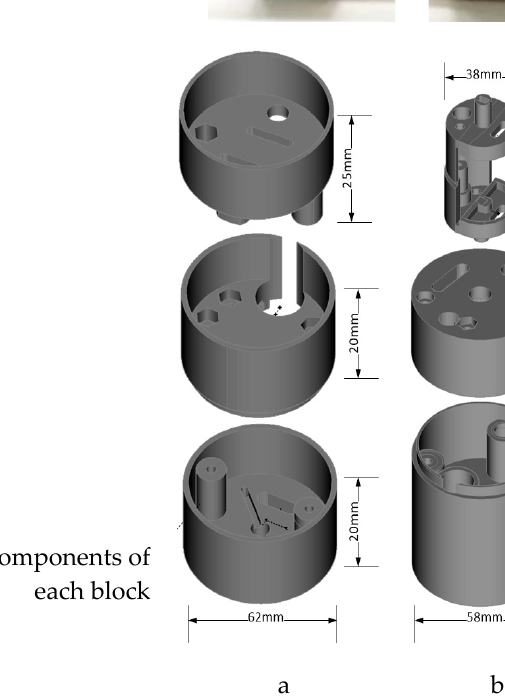
Figure 3. 3D-printed camera mount and locomotive parts. ( a ) System base, ( b ) camera mounts, and ( c ) bottom support.